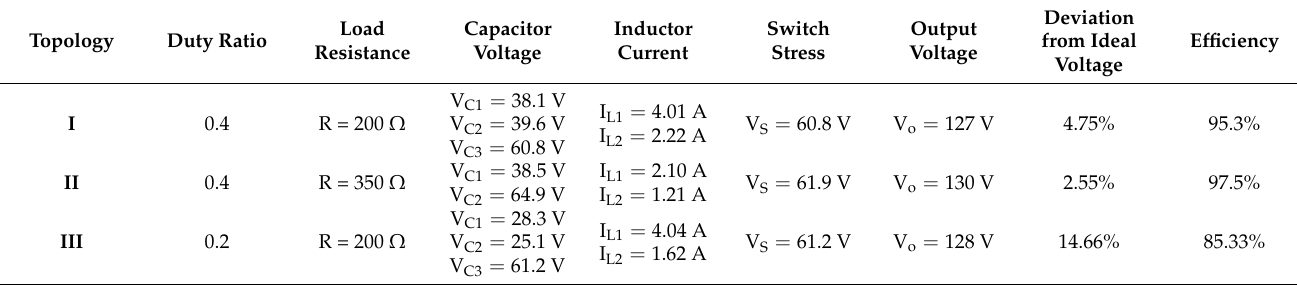
Table 6. Experimental results.